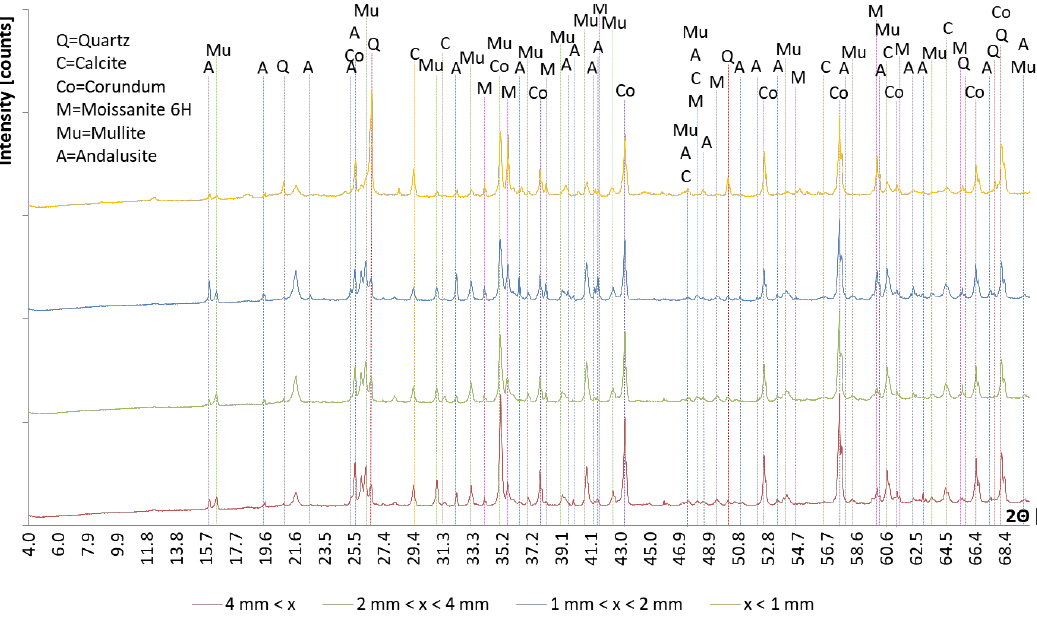
Figure 4. XRD pattern of precursor’s fraction above 4 mm (red line), between 2 mm and 4 mm (green line), between 1 mm and 2 mm (blue line) and below 1 mm (orange line). In the legend, minerals are: quartz (SiO 2 , card number ICSD 98-015-6196), calcite (CaCO 3 , card number ICSD 98-015-8258), corundum (Al 2 O 3 , card number ICSD 98-016-0604), moissanite 6H (SiC, card number ICSD 98-015-6190), mullite (Al 1.83 O 4.85 Si 1.08 , card number ICSD 98-004-3298) and alusite (Al 2 SiO 5 , card number ICSD 98-008-4614).